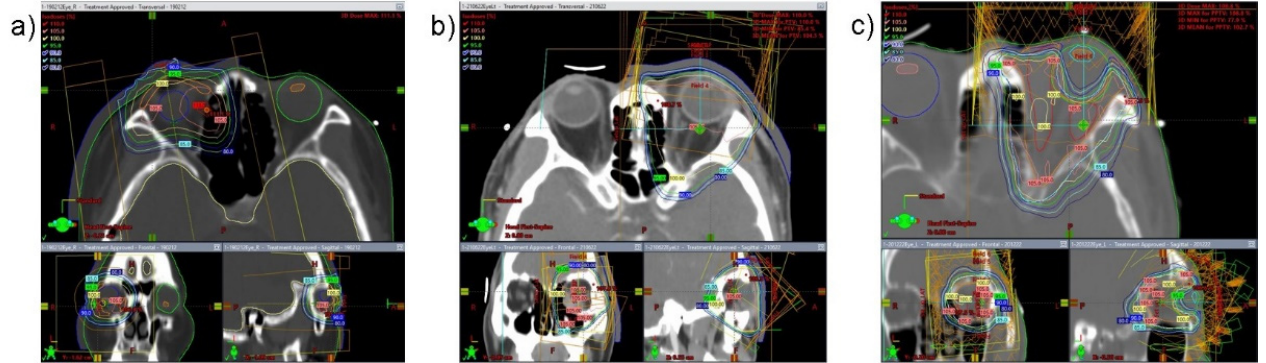
Figure 2. Radiotherapy planning for orbital MALToma: ( a ) electron therapy for conjunctival MALToma with lens shielding and Superflab bolus; ( b ) three-dimensional conformal radiotherapy with non-coplanar beam arrangement for mass invading both the conjunctiva and retrobulbar area; ( c ) intensity-modulated radiotherapy for retrobulbar MALToma.